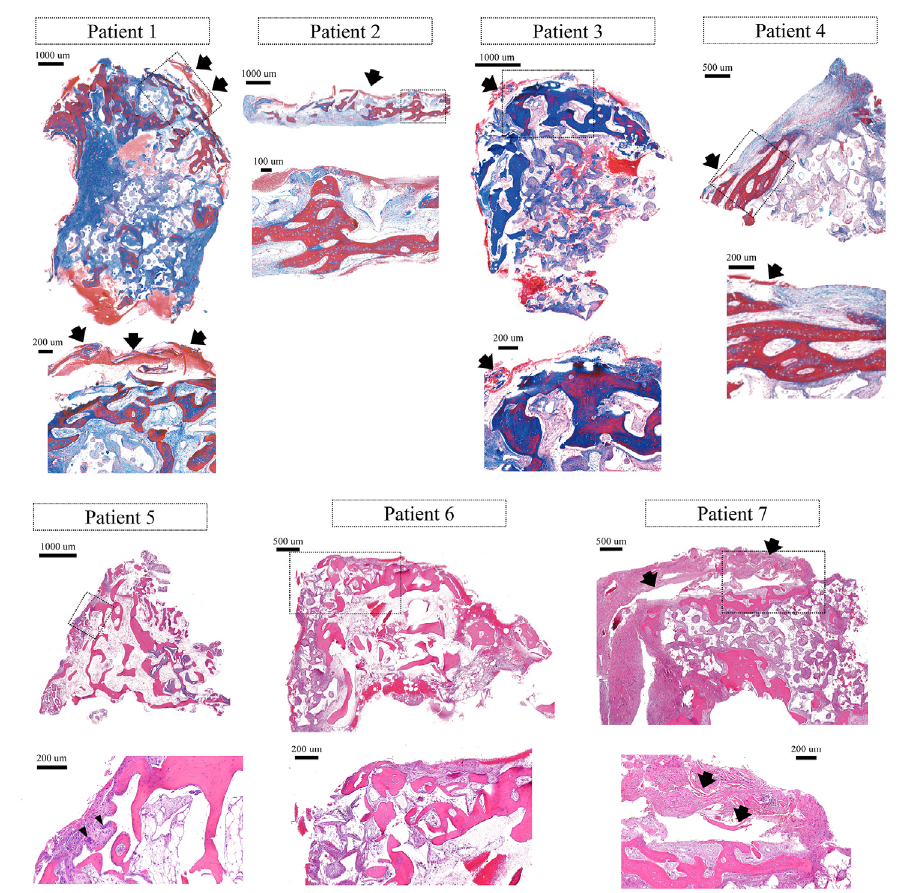
Figure 3. Histologic views of each case. Arrows indicate the remnants of a cross-linked collagen membrane. Arrowheads indicate multinucleated giant cells. Higher magnified views are presented for the box areas of the lower magnified views. Masson’s trichrome staining for the samples from patients 1–4. Hematoxylin-Eosin staining for the samples from patients 5–7.